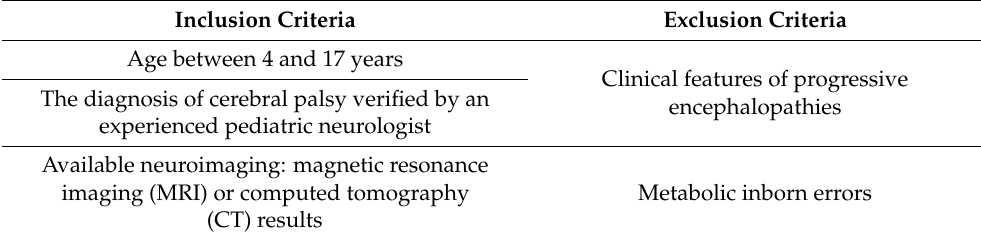
Table 1. Inclusion/exclusion criteria used to extract the most relevant records from the hospital data system.